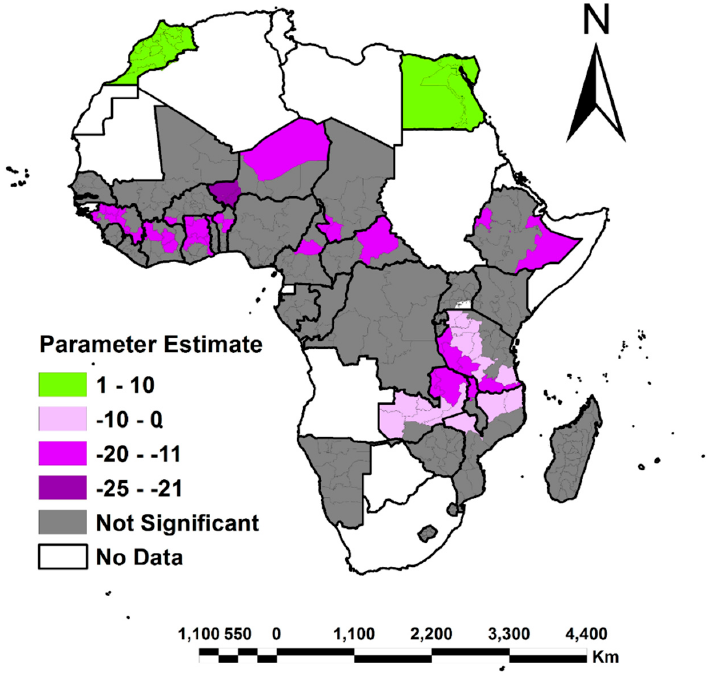
Figure 20. Spatial distribution and significance of HIV on women’s access to family land.